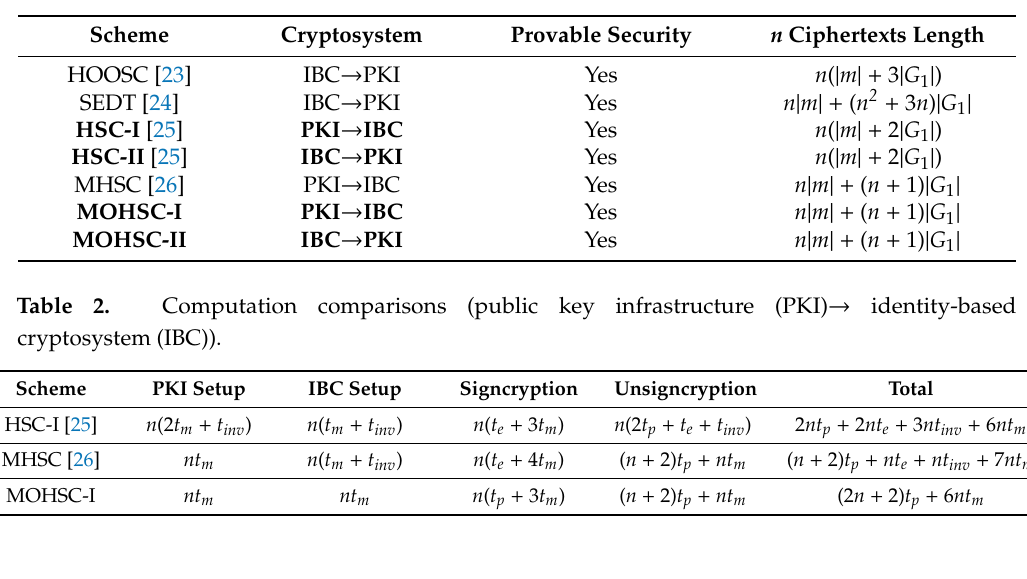
Table 1. Function comparisons.